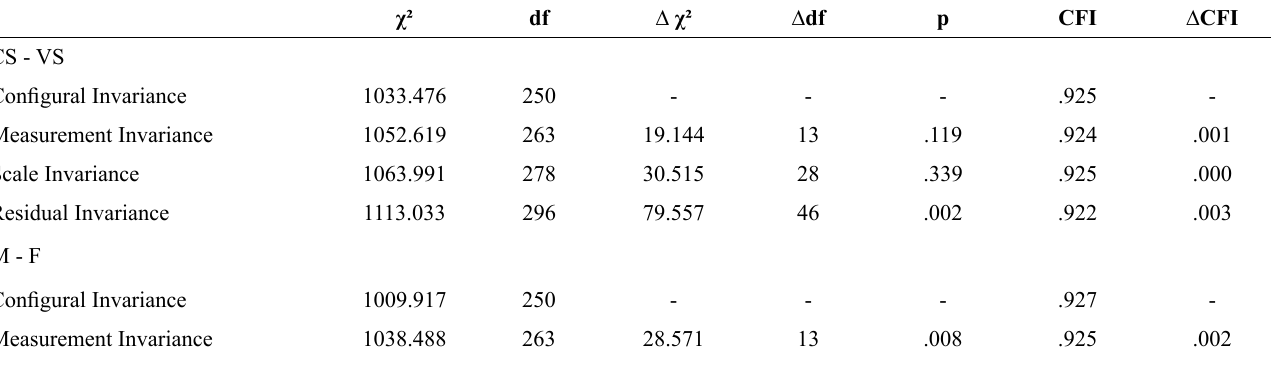
Table 4 Fit indices for the invariance of the measurement model of the PLOCQ in the Portuguese sample across